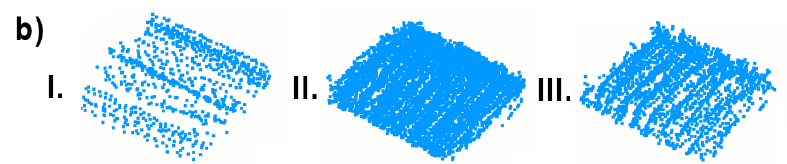
Figure 21. Point cloud resolution comparison for object (b)—isometric views.